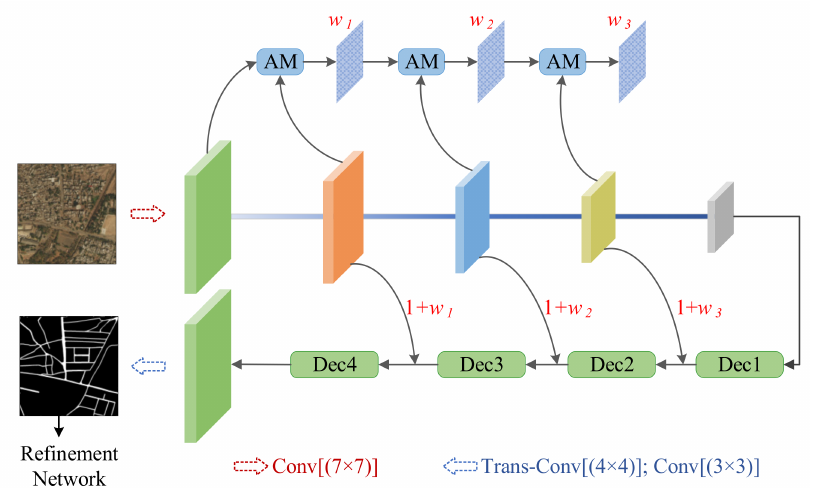
Figure 1. The architecture of the proposed network. A self-attention mechanism is exploited to enhance the inter-layer features. The final road maps are obtained through a refinement